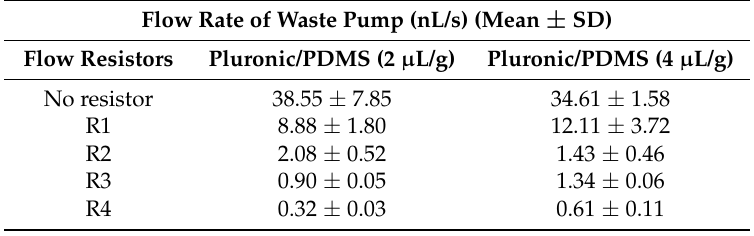
Table 4. Flow rates of plasma in the waste capillary